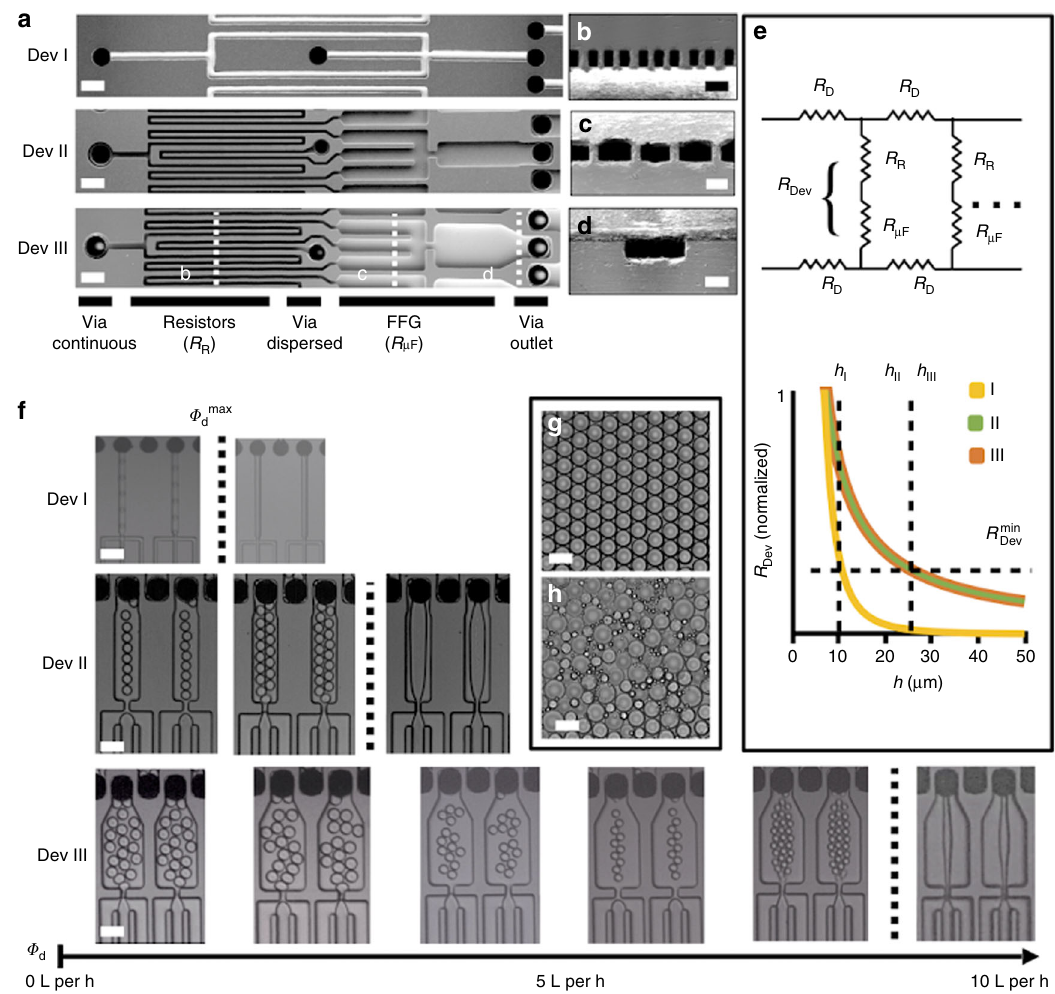
Fig. 2 Individual droplet generator design for high-throughput emulsion generation. a SEM images of the three fl ow-focusing droplet generator designs used in our study. Each FFG design occupies the same footprint (175 µ m × 1475 µ m), and for each design 10,260 were incorporated onto a VLSDI chip using the ladder architecture. Scale bars of all SEM images: 65 µ m. b – d shows cross-sections of Dev III. Scale bar: 30 µ m. e A lumped circuit model of our droplet generators. The graph shows the resistance of an individual droplet device R Dev vs. the channel height h . The inclusion of high aspect ratio resistors in Dev II and Dev III, leads to R Dev decreasing at a rate less than R Dev ∝ 1/ h 3 of the traditional design Dev I. Thus, the minimum resistance R min incorporate 10,260 FFGs can be achieved at a greater height h for Dev II and Dev III that enable operation at a higher fl ow rate before transitioning from the dripping to jetting regime. f Optical micrographs of droplet generators producing hexadecane droplets in water at various dispersed phase fl ow rates ϕ d for Dev I, II, and III. The maximum fl ow rate ϕ d max possible, while keeping the devices in the dripping regime, using Dev III ( ϕ max = 7.3 L h − 1 ) is greater than Dev II ( ϕ max = 3.5 L h − 1 ), which is greater than Dev. I ( ϕ max = 0.35 L h − 1 ). Scale bars of all images: 65 µ m. g An example of droplets formed when in